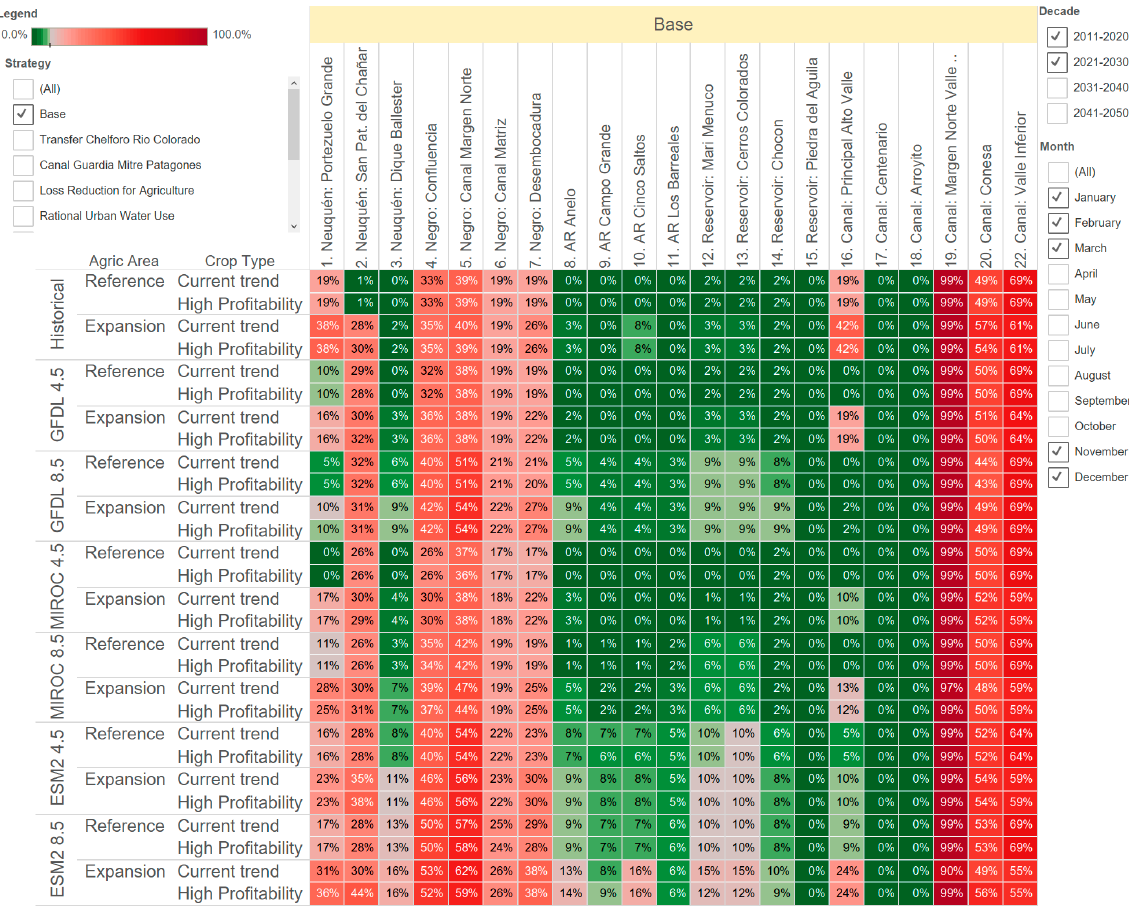
Figure 5. Current management in short term: The color dimension of the visualization is designed so shades of green means the performance metrics fails 10% (or less) of the time. Shades of red show the performance metric fails between 11% and 100% of the time (darker shades of red when close to 100% and lighter shades of red when closer to 11%) [34].